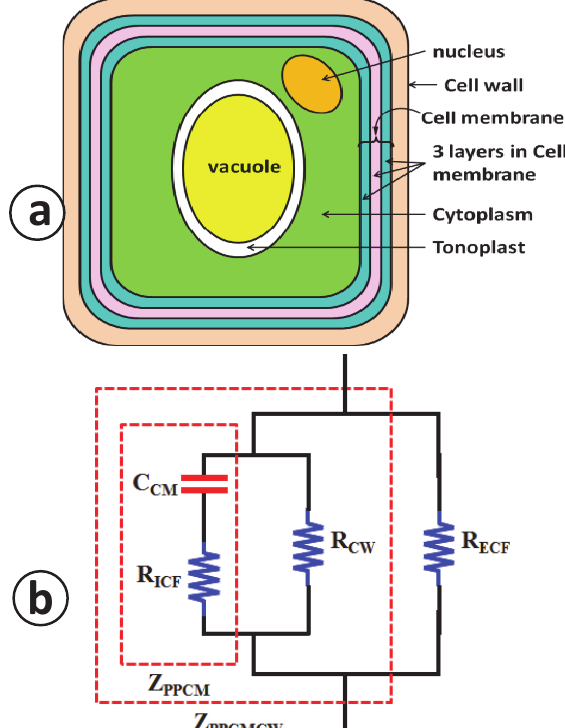
Fig.5: Equivalent electrical circuit modeling of plant cells. (a) The anatomy of an isolated plant cell showing intracellular fluids (ICF), extracellular fluids (ECF), the cell membrane (CM) and cell wall (CW). (b) An equivalent electrical circuit model of an isolated plant cell without considering tonoplast capacitance.